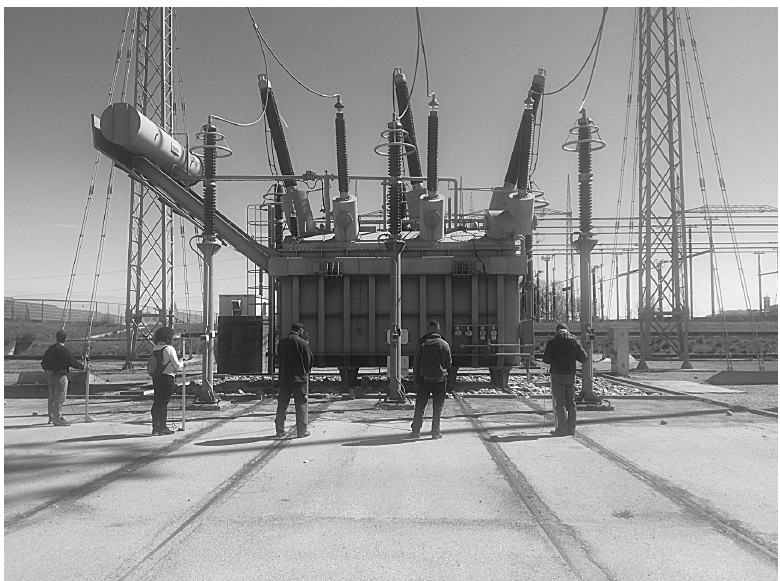
Figure 5. An example of directivity measurement around a